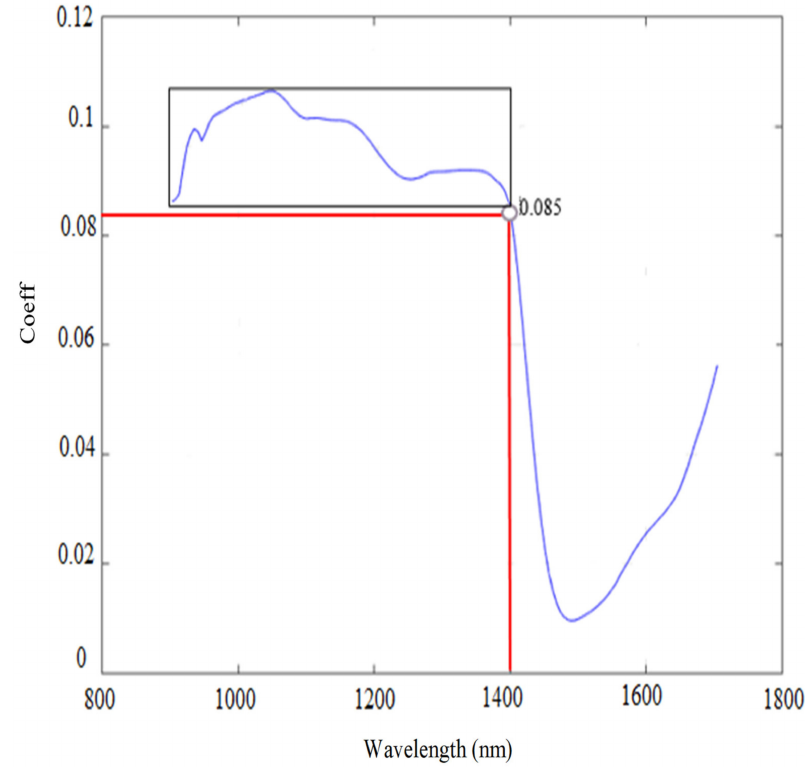
Figure 12. The coefficients of PC1 as a function of